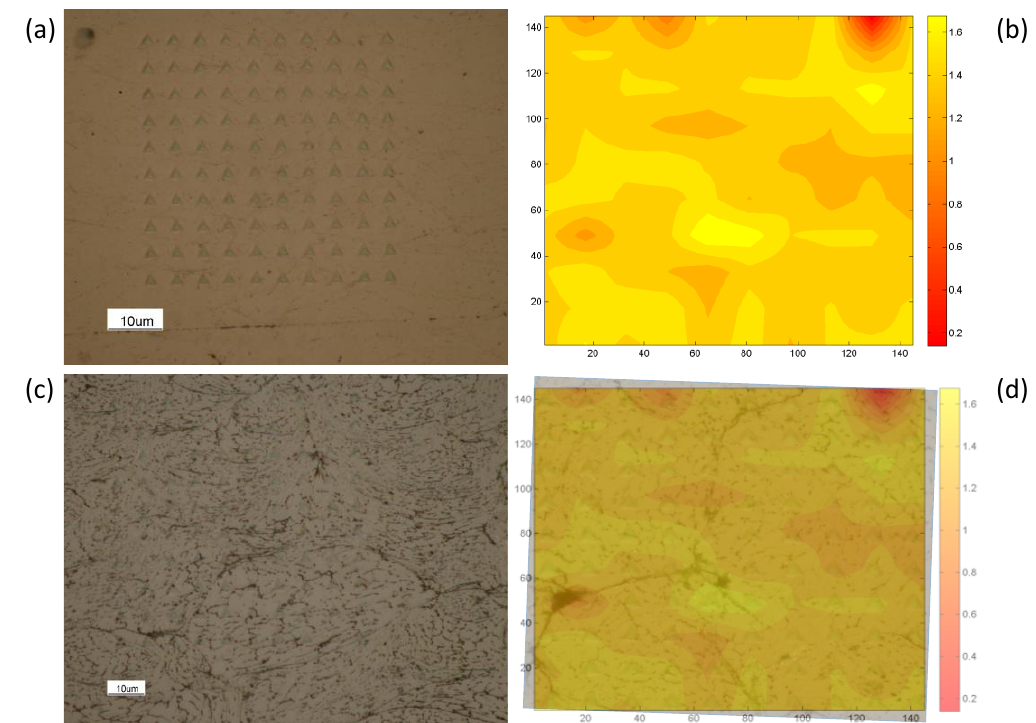
Figure 41. ( a ) Captures the optical micrograph of the Al 6061 cold spray consolidation in the cross-sectional orientation relative to the deposition direction. ( b ) Captures the hardness contour plot using the indentation grid and location-specific 2D data from ( a ). ( c ) Depicts the same material region and indents presented in ( a ); however, the indented material was etched to reveal grain-related microstructural features in relation to their hardness’s depicted in ( b ). ( d ) Overlays the contour plot associated with ( b ) upon the etched micrograph in ( c ) for explicit microstructure-hardness comparison and